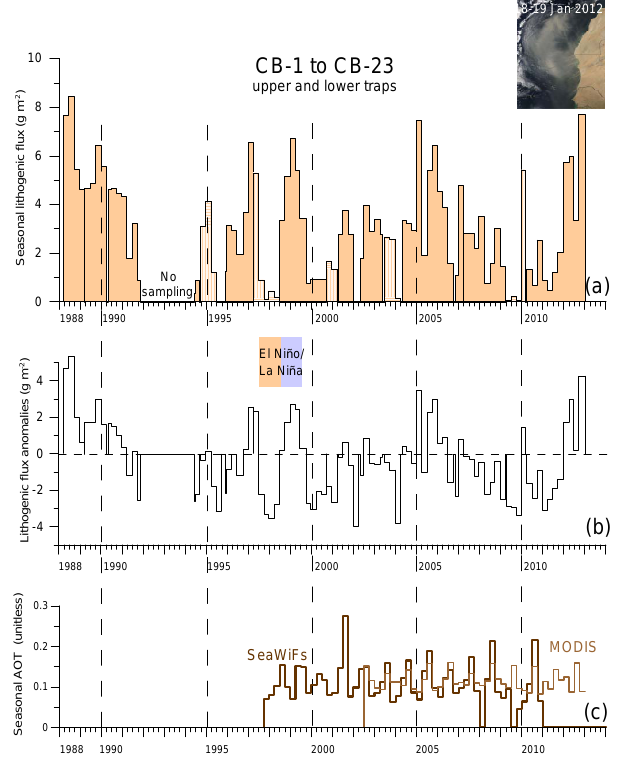
Figure 8. (a) Seasonal flux of lithogenic ( = mineral dust) parti- cles (orange) with gaps filled from the upper trap data (light or- ange bars). Deviations from the long-term seasonal means (anoma- lies, b ). Note the large positive anomalies with longer duration in 2005, lithogenic fluxes remain rather low. In 2005, dust sedimenta- tion and BSi flux (Fig. 6b) were high throughout the year. (c) The AOT from the SeaWiFS (brown) and MODIS (light brown) sensors shows repeatedly high values in summer, but not in winter when dust sedimentation is highest in the study area. A typical short-term (2-day) dust storm in January 2012 is shown as insert in the upper right. The strong ENSO cycle 1997–1999 with a warm El Niño and a cold La Niña phase is